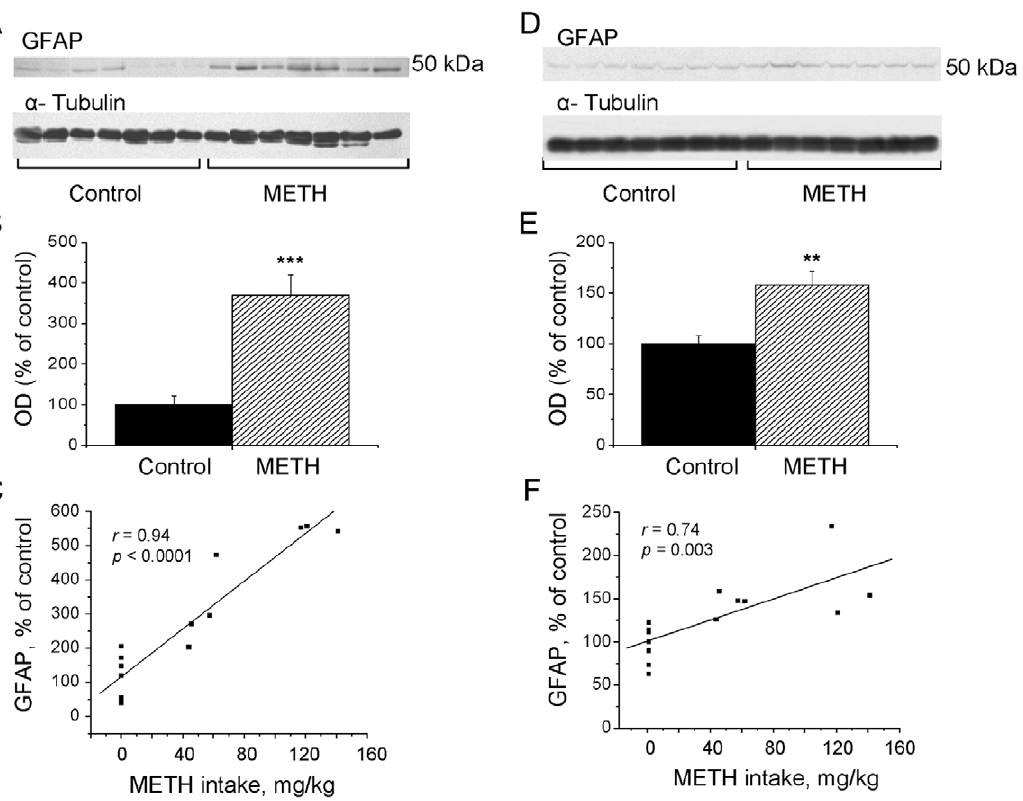
Figure 6. Effects of METH self-administration on GFAP expression in the striatum and cortex. Representative Western blot analyses show that the METH self-administering rats had increased GFAP levels in their striata (A) and cortices (D). Quantitative analyses of the Western blots show significant increases in GFAP levels in the METH-treated rats (B, E). Key to statistics: ** p , 0.01, *** p , 0.001 (ANOVA, n=7 per group). GFAP expression showed significant positive correlation with METH intake in the striatum (C) and cortex